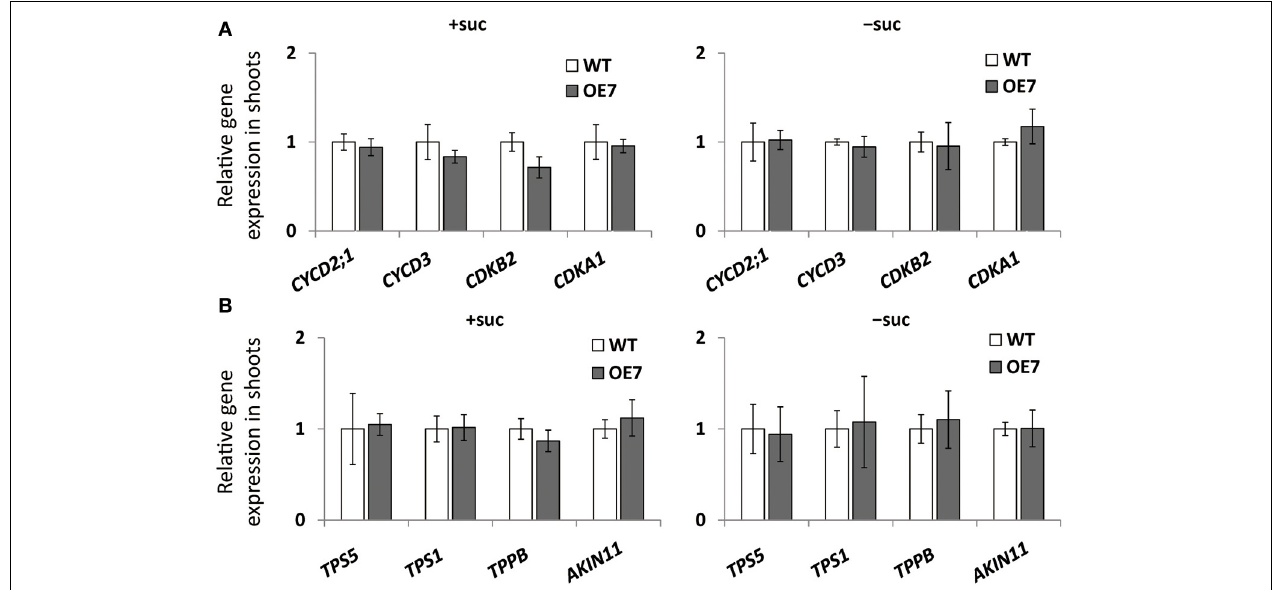
FIGURE 7 | Cell cycle–related gene (A) and trehalose-6-phosphate (T6P)-metabolism-related gene (B) expression in WT and OE7 seedlings. Plants grown on MS agar with + suc or − suc for 7d were then were transferred to ½MS agar with or without sucrose, respectively, for another 7d. Relative mRNA abundance of cell cycle–related genes